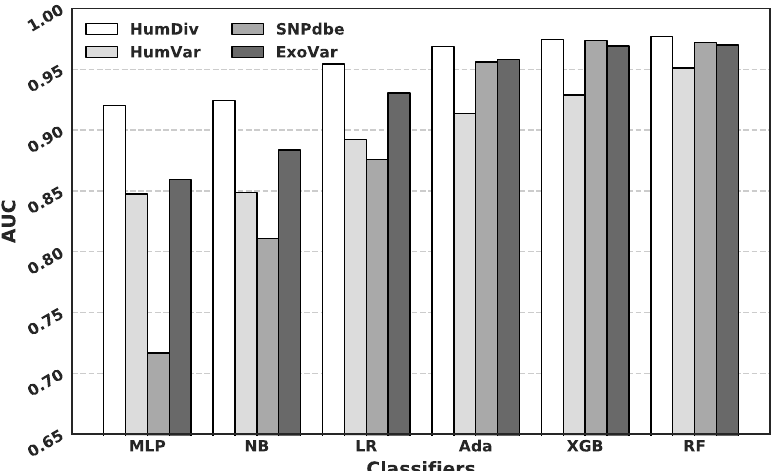
Figure 3. AUCs for the predictions generated by the six considered machine-learning algorithms on the four benchmark datasets. Table 2. AUCs for DMBS, two the DMBS variants (DMBS_BR and DMBS_MSA), and three current predictors of deleterious nsSNPs on the HumDiv and HumVar benchmark datasets. The AUCs were calculated based on the 10-fold cross validation. The highest AUC values for each dataset are highlighted in bold font. Summary of the benchmark datasets used in this